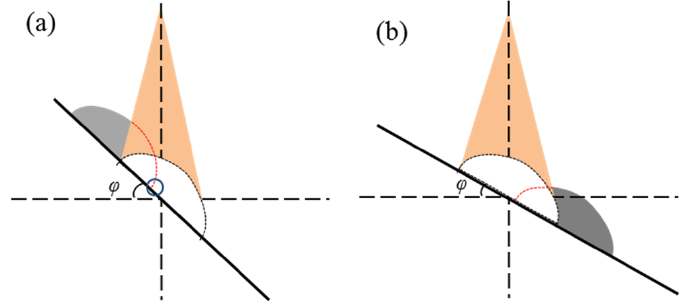
Figure 9. Laser beam range of different lap directions: ( a ) downward; ( b ) upward.